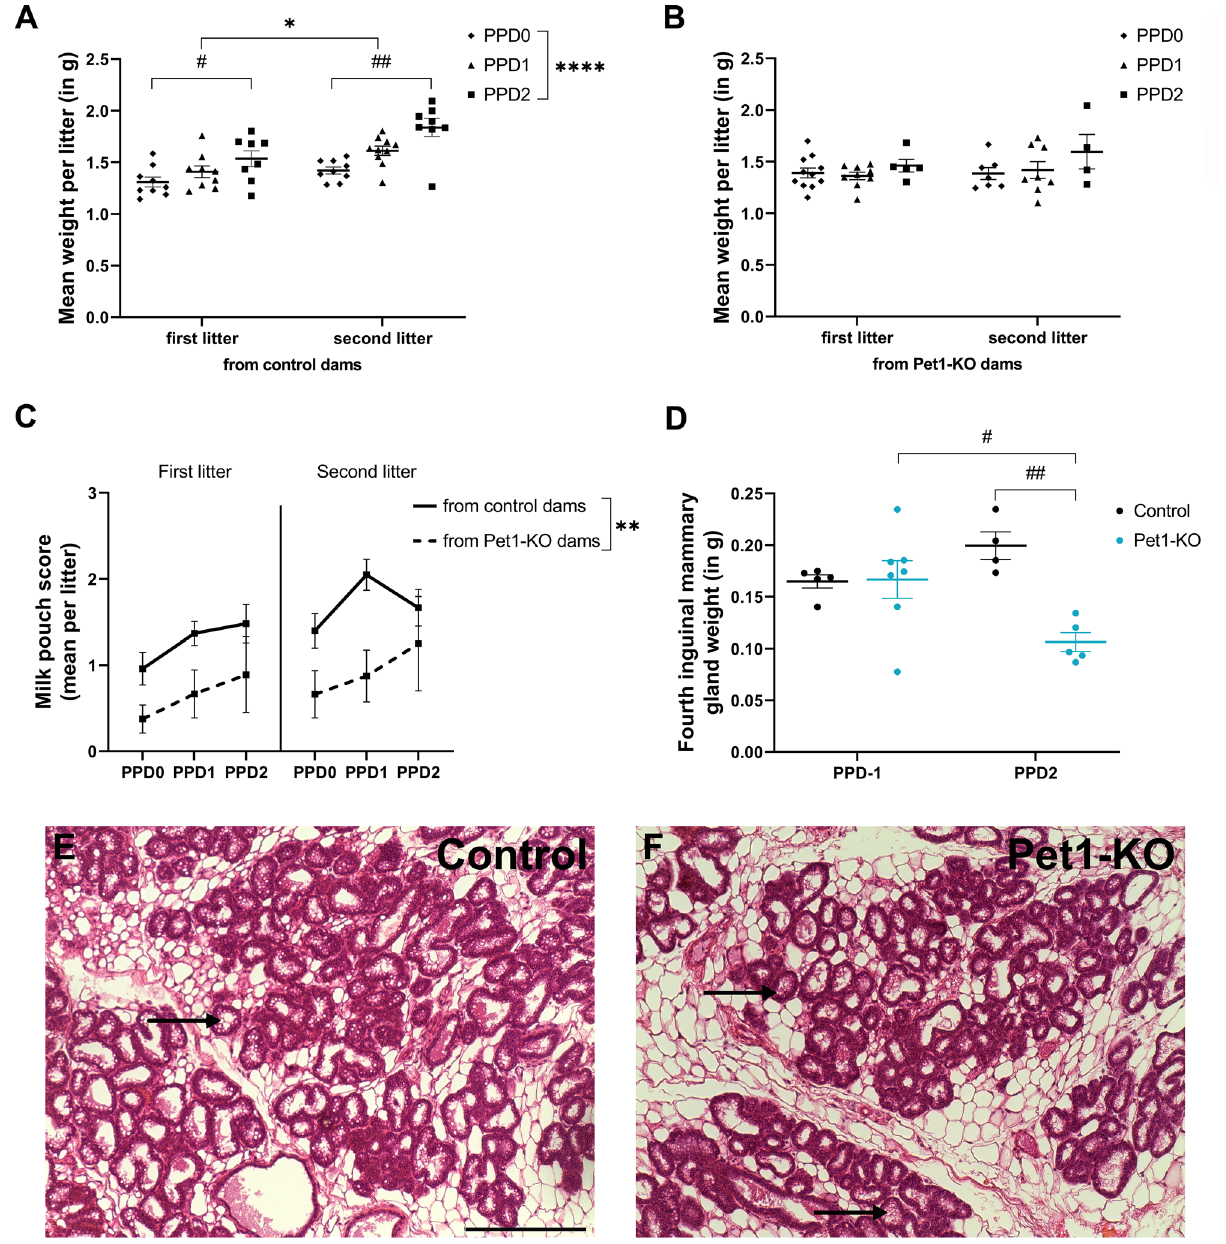
Figure 3. Defect in pup survival in the Pet1-KO mice is associated to reduced milk intake despite normal mammary gland development. ( A ) Pups of the first (n = 9) and the second litters (n = 10) raised by control (Pet1 +/− ) dams showed a significant weight gain during their first two postnatal days, with a significant effect of maternal experience; * p < 0.05, **** p < 0.0001 (mean per litter ± SEM, repeated-measures two-way ANOVA followed by Tukey’s comparisons: # p = 0.011; ## p = 0.004). ( B ) Pups of the first (n = 10) and second litters (n = 8) raised by Pet1-KO dams did not show weight gain between PPD0 and PPD2, no matter the reproductive experience of the mothers; (mean per litter ± SEM; repeated-measures two-way ANOVA). ( C ) Milk pouch of pups born by Pet1-KO dams was consistently smaller than in pups of control dams. No matter the genotype of the dams, there was no significant change in the milk pouch size of their pups between PPD0 and PPD2, nor any effect of maternal experience, mean per litter ± SEM, ** p < 0.01 (repeated-measures three-way ANOVA). ( D ) The weight of the mammary gland was measured at late gestation and after pup delivery. 24hs prepartum (PPD-1) the mammary gland weight was comparable between Pet1-KO and control mice. 48hs postpartum (PPD2), the mammary gland weight of Pet1-KO dams was significantly reduced compared to controls, as well as vs. the ones from PPD-1 Pet1-KO (mean ± SEM, two-way ANOVA followed by Tukey’s comparisons: # p = 0.03; ## p = 0.003). ( E,F ) Hematoxylin/eosin-stained sections of mammary glands from PPD2 ( E ) controls and ( F ) Pet1-KO dams. Histological structure of the mammary tissue was comparable between mothers from both genotypes. Acini seemed smaller and less numerous in the Pet1-KO dams ( F ) compared to controls ( E ), but they contain small lipid droplets, that correspond to milk presence (black arrows). Scale bar = 200